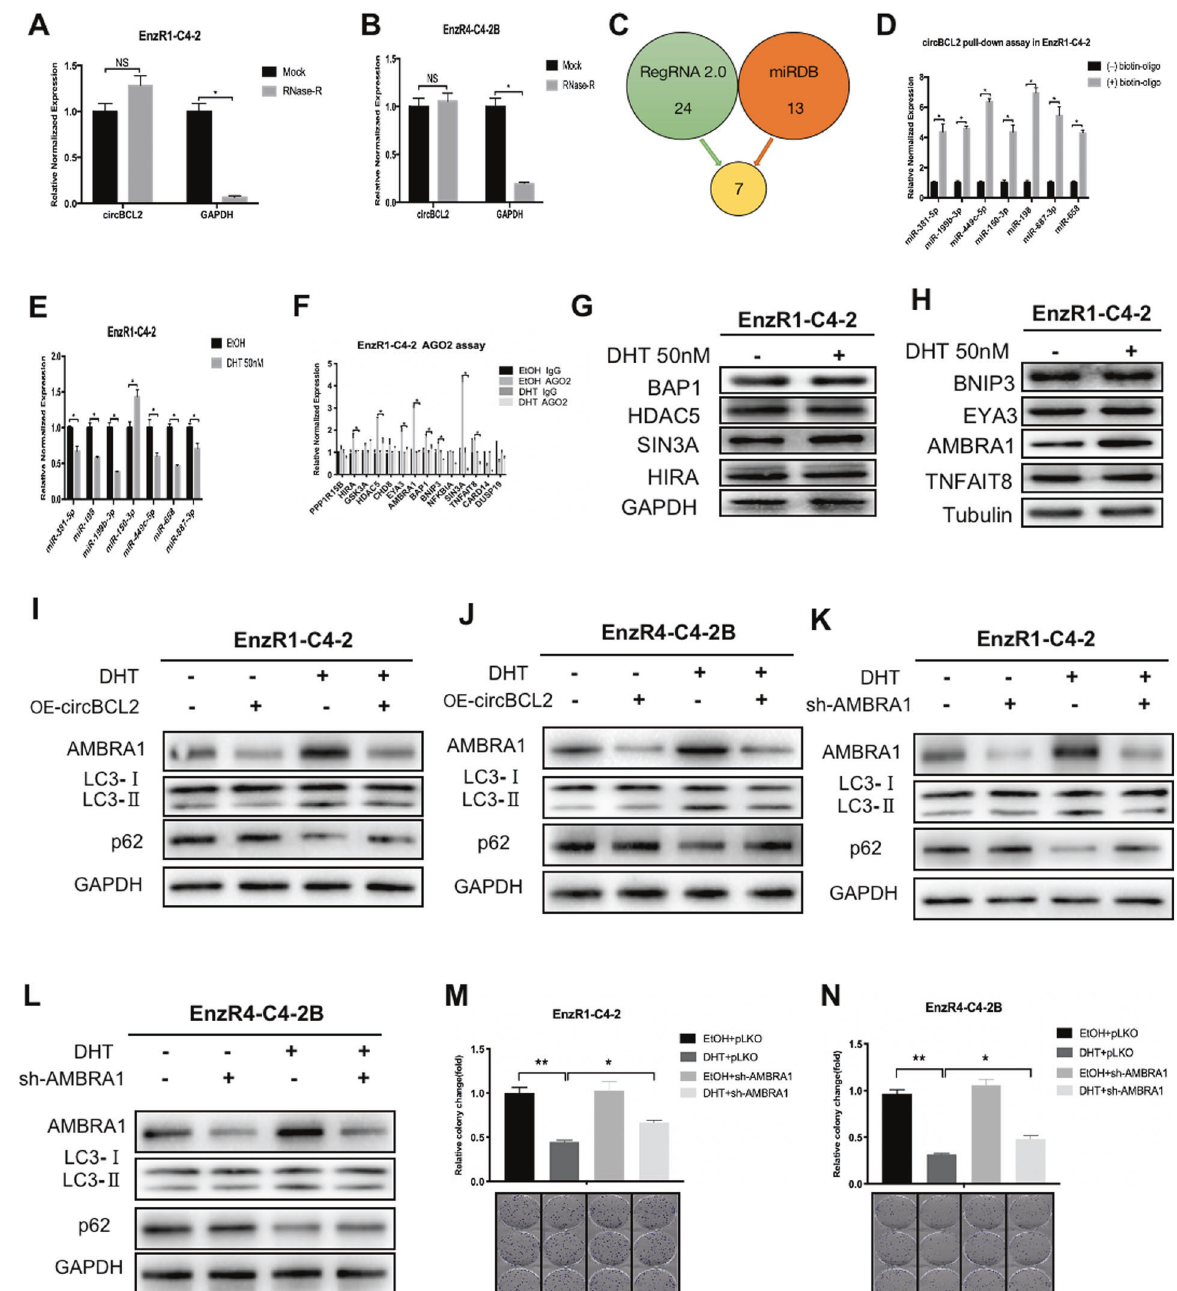
Fig. 4 Mechanism dissection of how DHT/circRNA-BCL2 induces autophagic cell death in EnzR PCa cells: via regulating the AMBRA1 expression. A , B RNase R assay to determine the sensitivity of circBCL2 by RNase R digestion in EnzR1-C4-2 ( A ) and EnzR4-C4-2B ( B ) cell lines. C Venn diagram for prediction of the potential miRNAs using two miRNA related websites (miRDB and Regrna2.0). D Seven miRNA candidates can physically interact with circRNA-BCL2 and showed up after screening EnzR-C4-2 cells by biotin-circRNA-BCL2 pull-down assay. E The qRT- PCR was performed to show quanti fi cation of circRNA-BCL2 related miRNAs expression in EnzR-C4-2 cells after 50 nM DHT treatment. F Argonaute2 (AGO2) IP assay to detect 14 candidate genes mRNA in AGO2 complex and results revealed that 8 genes have less miRNAs binding in EnzR-C4-2 cells after 50 nM DHT treatment. G , H Western blot assays were performed to show candidates genes expression in EnzR- C4-2 cells after 50 nM DHT treatment. I , J Western blot assays show AMBRA1, LC3, and p62 expression after oe-circRNA-BCL2 in EnzR1-C4-2 ( I ) and EnzR4-C4-2B ( J ) cell line with 50 nM DHT. K , L Western blotting show AMBRA1, LC3 and p62 expression after sh-AMBRA1 in EnzR1-C4-2 ( K ) and EnzR4-C4-2B ( L ) cell line with 50 nM DHT. M , N Colony formation assays show cell growth with 50n M DHT when sh-AMBRA1 is transduced in EnzR1-C4-2 ( M ) and EnzR4-C4-2B ( N ) cell lines. Data are presented as means ± SD. * p < 0.05, ** p < 0.01, NS not signi fi cant. after DHT (50 nM) treatment (Fig. 4G, H), suggesting that AMBRA1 is likely a direct target for the DHT initiated signaling, consistent with our earlier fi ndings that autophagic cell death was likely mediating the growth suppression by DHT. Cell Death Discovery (2022)